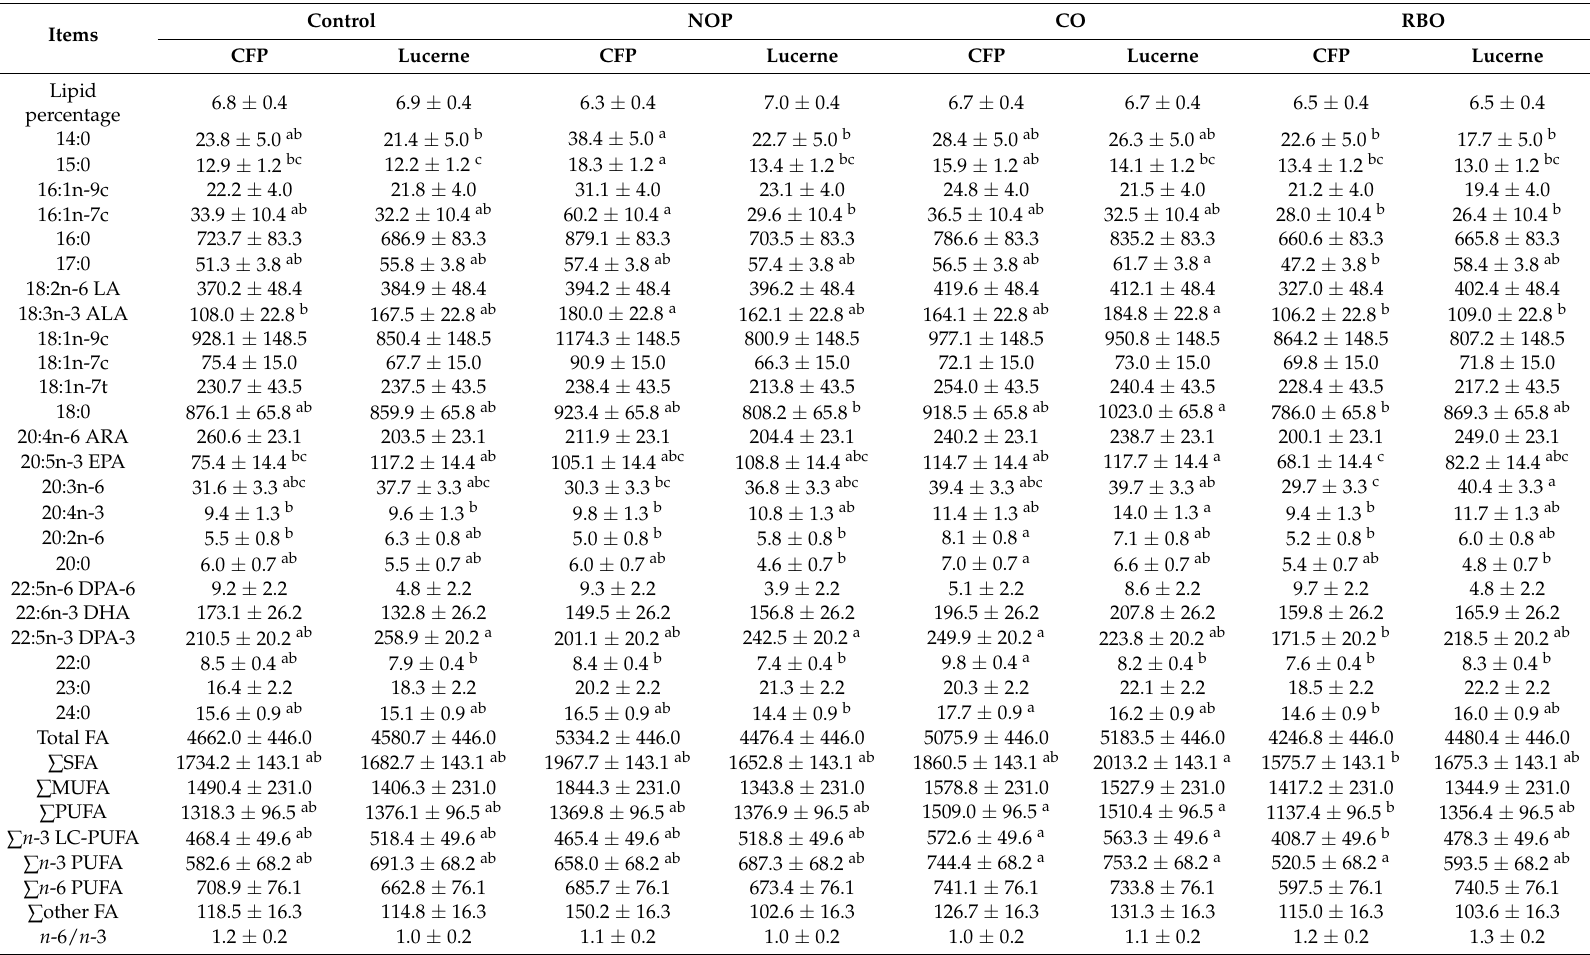
Table 4. Effect of pellet supplementation on total lipid percentage (g fat/100 g) and fatty acid contents (mg/100 g) in liver of grazing prime lambs (LSM ± SE)